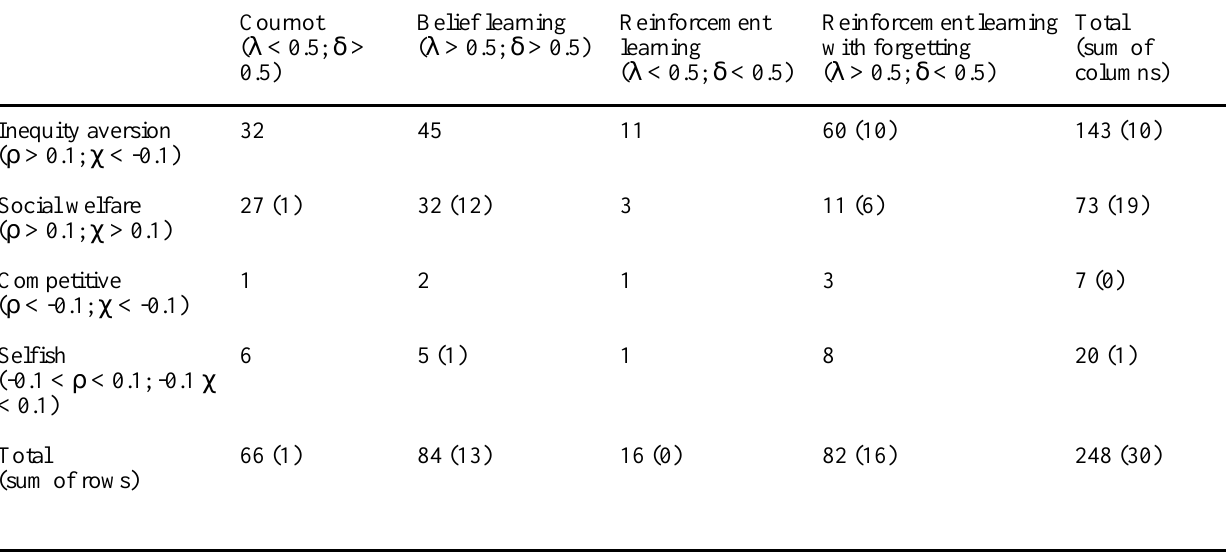
Table 8 . Classification of players based on the estimated parameter values. The parameters are defined in Table 2. The 248 players in the 10-round experiments are classified into 16 possible cases. The total number for each type of learning model is given in the last row, and the total number for each type of utility function is given in the last column. The 30 players of the 40/60-round experiments are also classified, and these numbers are given in